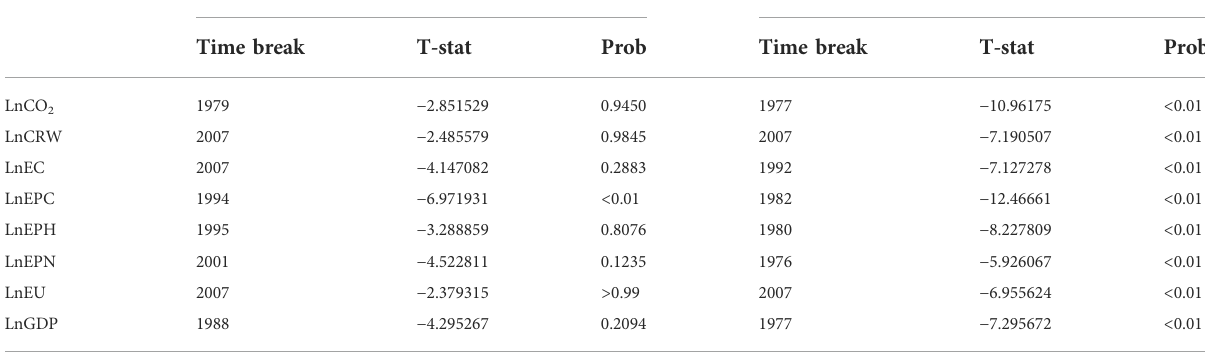
TABLE 6 Breakpoint unit root